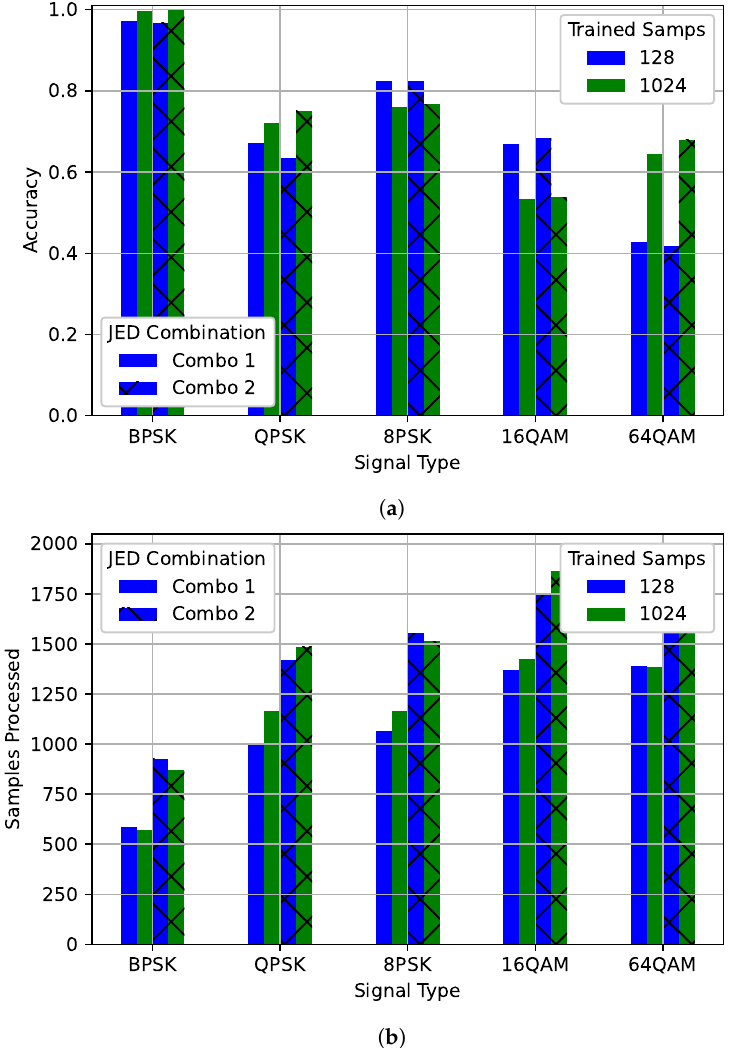
Figure 13. An examination of ( a ) accuracy and ( b ) the number of samples processed of JED for different modulations. The best model for 128 and 1024 are each shown after processing with two different JED